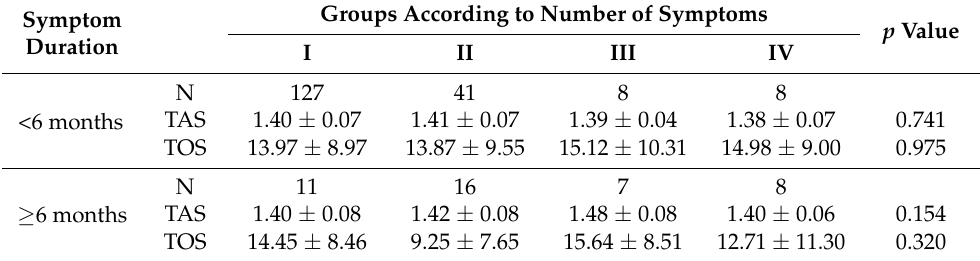
Table 4. Comparison of TAS/TOS (mean ± SD) among groups classified according to number and six-month duration of symptoms.